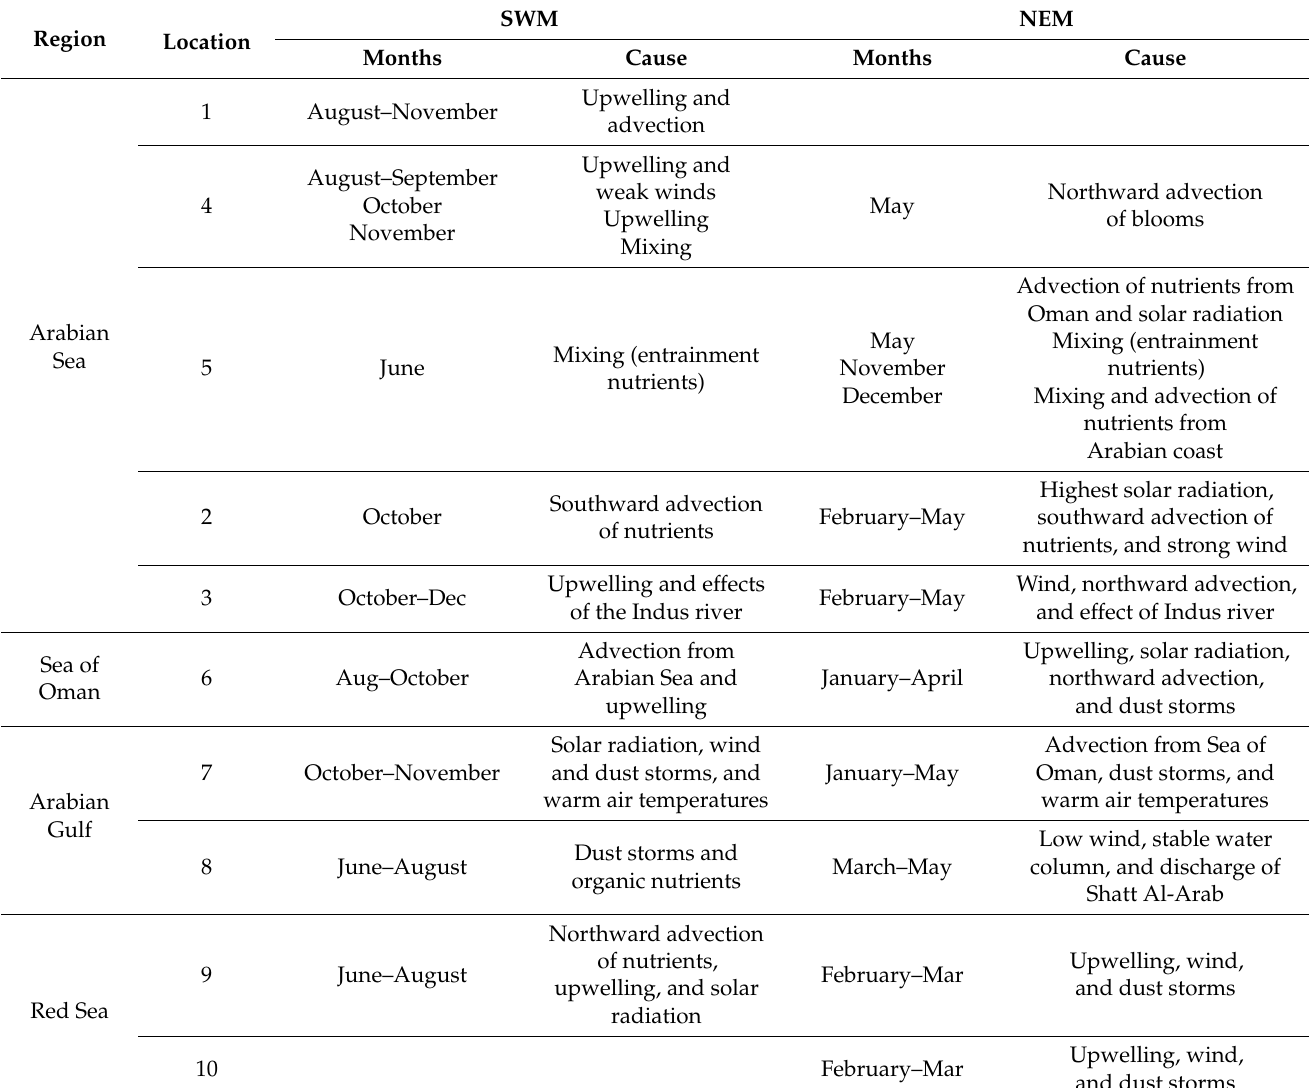
Table 1. Atmospheric and oceanic features associated with algal bloom events in each of the ten